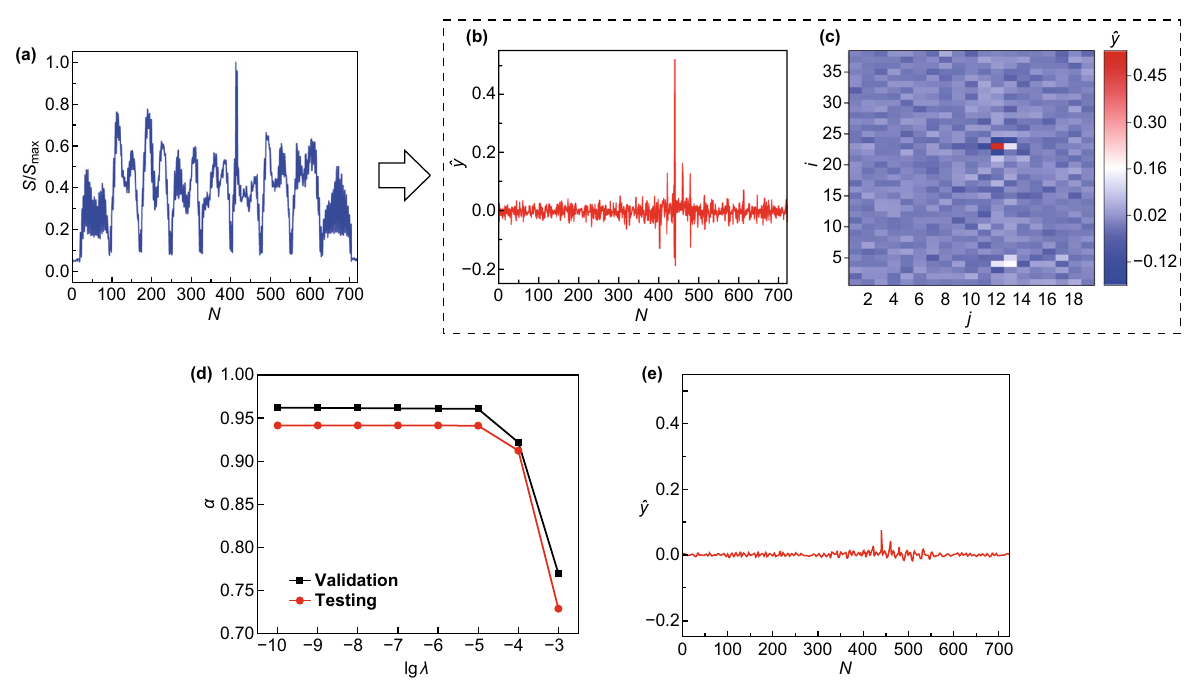
Fig. 2 Results of the atom-based machine learning prediction for a single-atom vacancy. a An example of energy vector from the test data. b Predicted label vector. c 2D presentation of the predicted label vector. d Validation and testing accuracies as a function of regularization param- eter 𝜆 . e Predicted label vector under a relatively strong regularization 𝜆 = 10 −